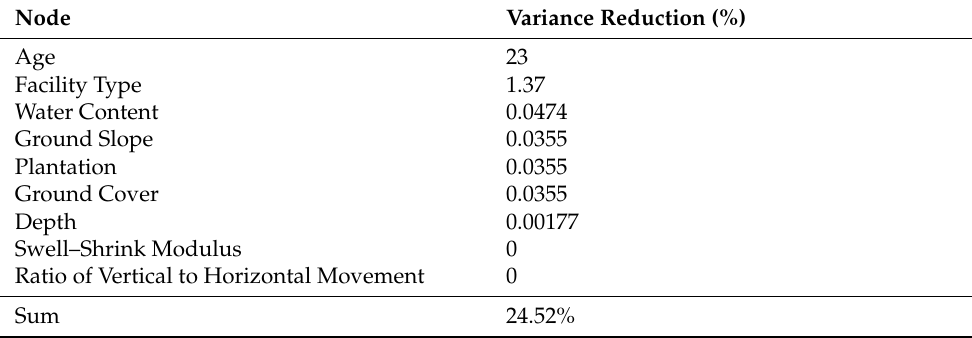
Table 3. Summary of sensitivity analysis.